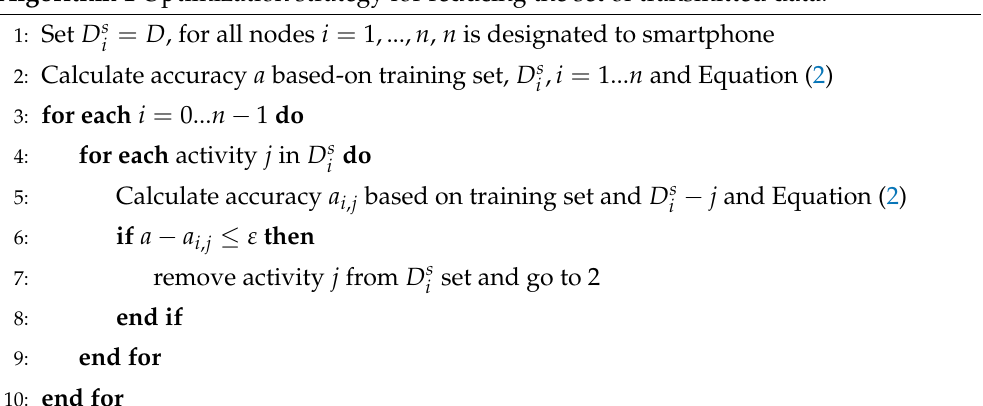
Algorithm 1 Optimization strategy for reducing the set of transmitted